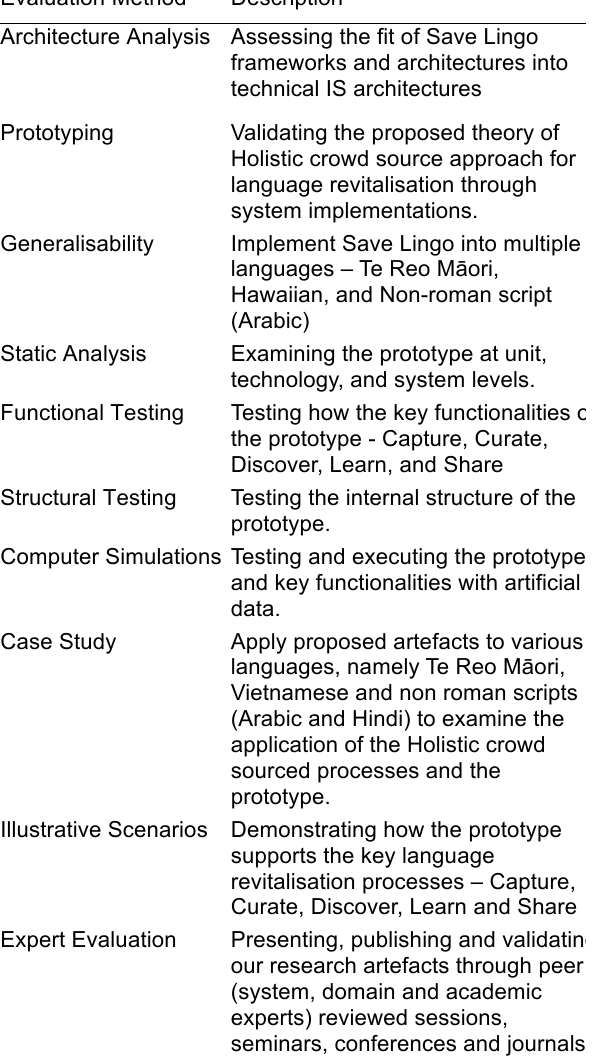
Table 2. Evaluation Methods